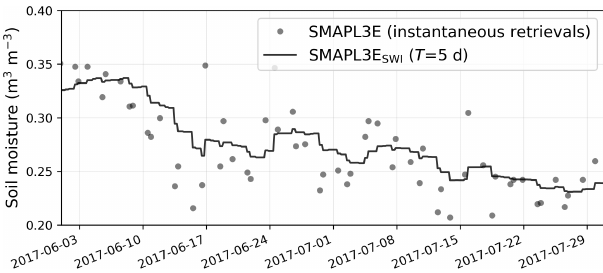
Figure 1. To illustrate the SWI filter, SMAPL3E instantaneous vol- umetric soil moisture retrievals (from both ascending and descend- ing overpasses) and 3-hourly SMAPL3E SWI time series obtained by application of the SWI filter (with the time lag constant T set to 5d) for a 2-month period at 34.82 ◦ N, 89.44 ◦